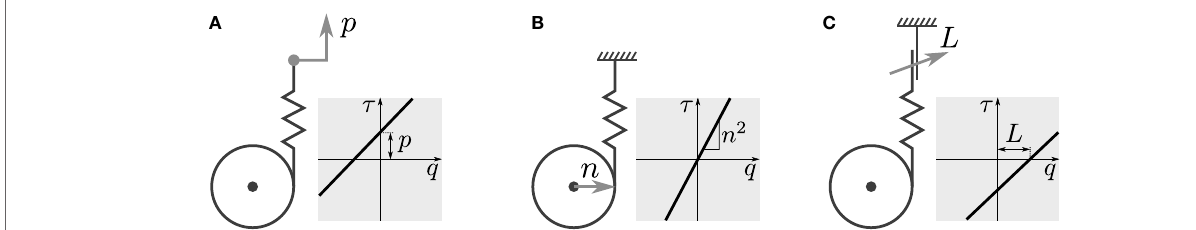
FIGURE 1 | Types of adjustability: (A) pretension, (B) transmission ratio, and (C) engagement mechanism.